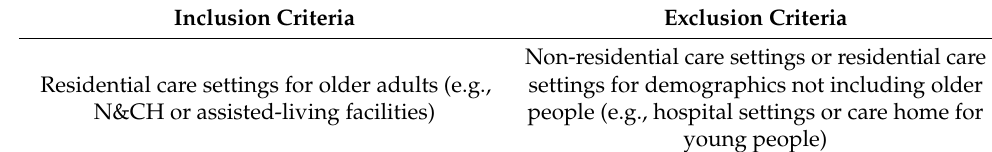
Table 3. Inclusion and exclusion